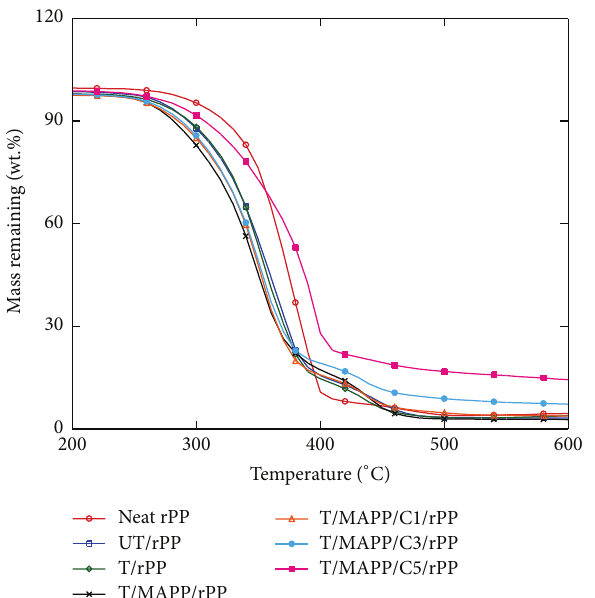
Figure 8: Effect of fiber treatment and nanoclay on sisal fiber/poly- propylene